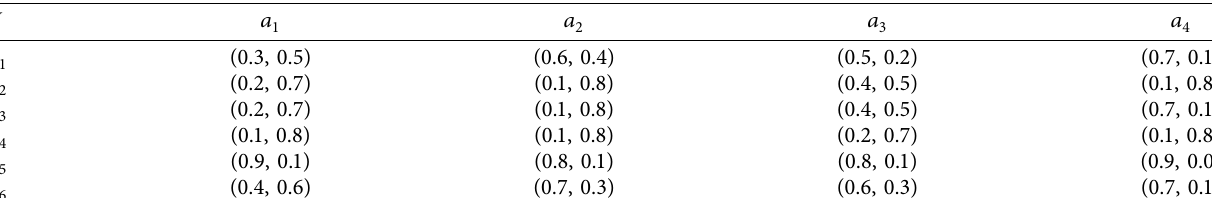
Table 1: Intuitionistic fuzzy information